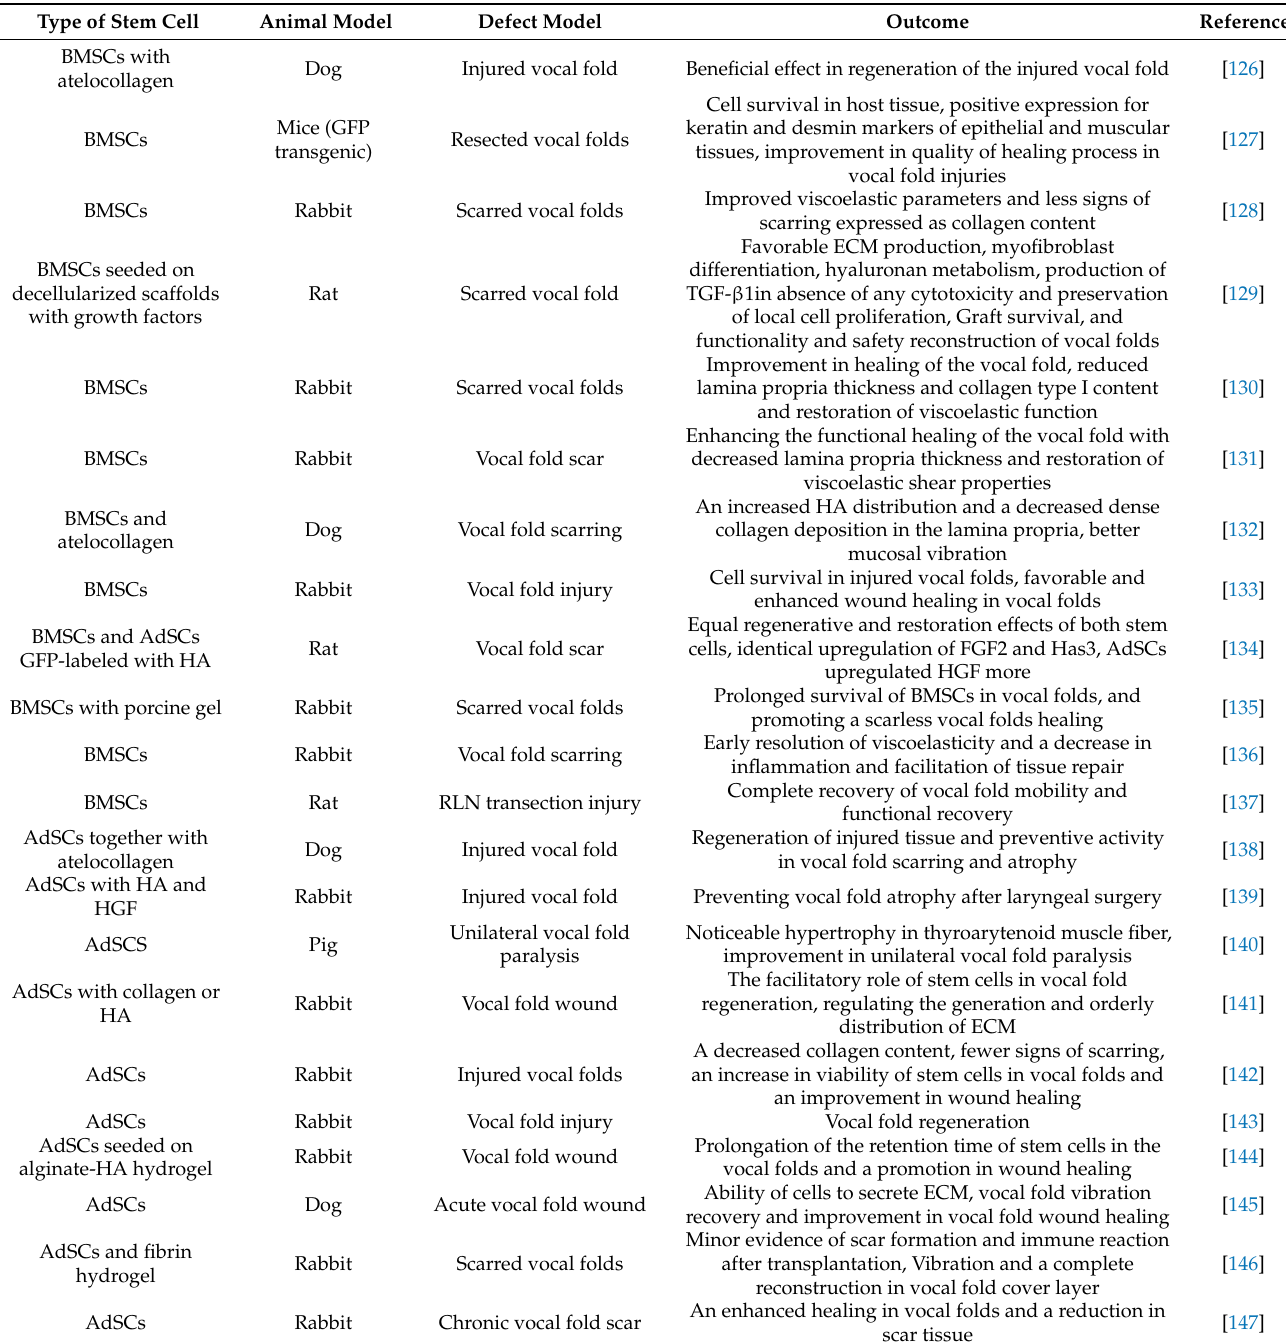
Table 5. In vivo studies of vocal fold